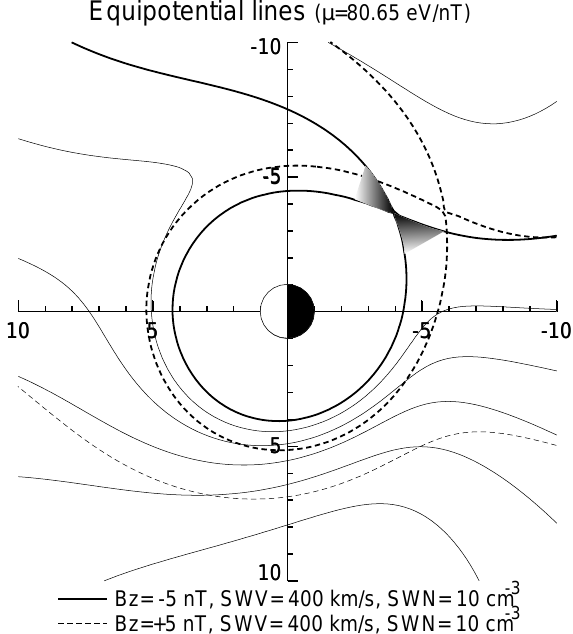
Fig. 4. Possible explanation for the ion gaps observed by Po- lar/MICS on 9 February 1998. Equipotential lines of the equato- rially mirroring ions with the magnetic moment µ of 80.65eV/nT (corresponding to the kinetic energy of 20keV at L = 5) under the corotation electric potential and the W2K convection potential for the southward IMF (solid line; IMF B z of − 5nT, the solar wind velocity of 400km/s and the solar wind density of 10cm − 3 ) and the northward IMF (dashed line; IMF B z of + 5nT, the solar wind velocity of 400km/s and the solar wind density of 10cm − 3 ) are plotted at the interval of 10kV. Separatrix between the open and closed drift paths is indicated by a thick line. IMF B x and B y were kept constant at